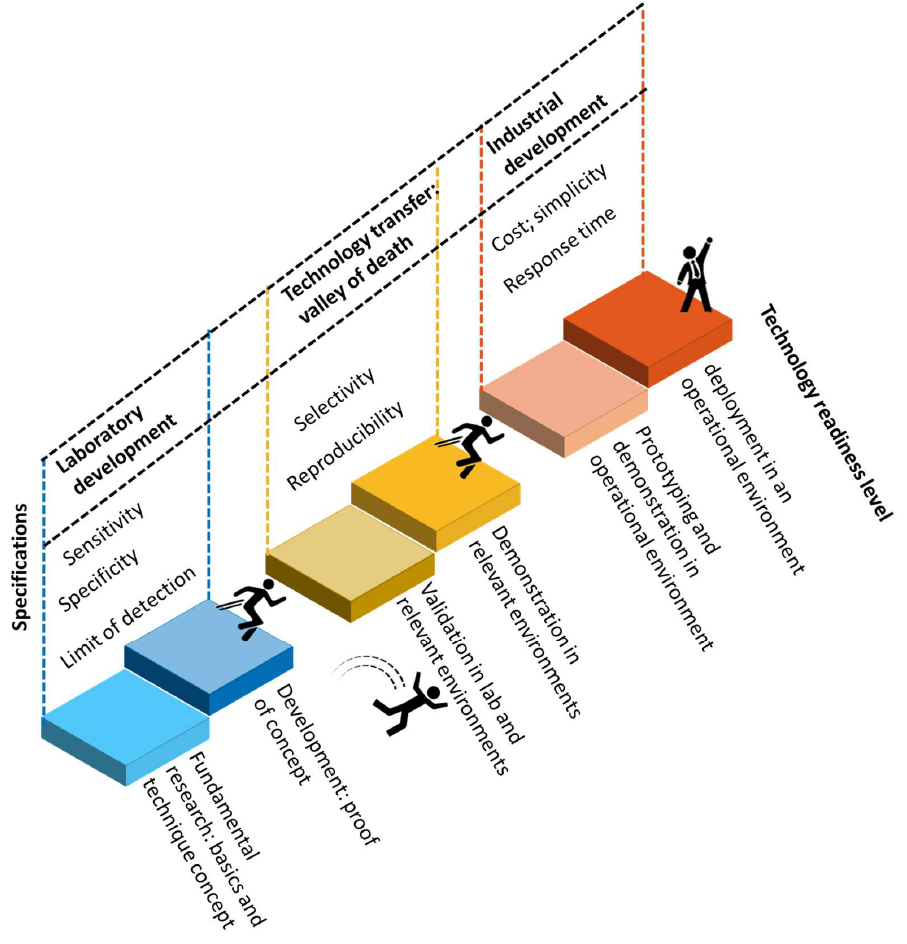
Figure Figure 3. Challenges during the different development stages of a biosensor for commercialization/ready-to-use.